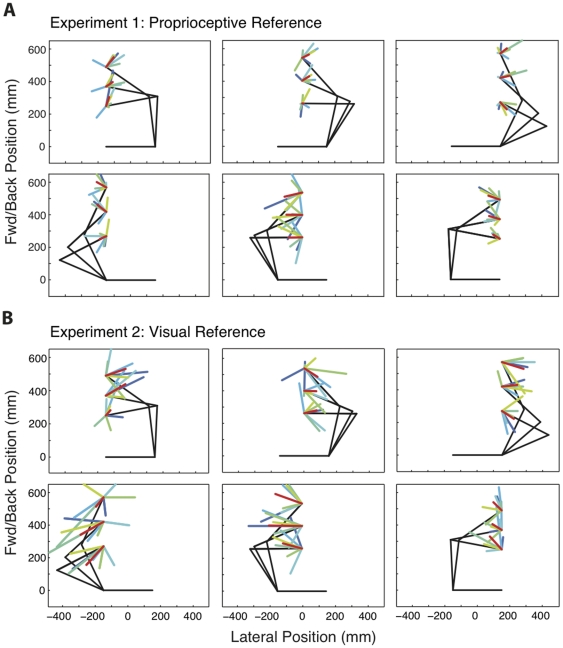
Proprioceptive Bias across the workspace.Proprioceptive bias is plotted as a vector (the vector sum of bias in the left-right and forward-backward directions) for individual subjects (gray) and the group mean (black), for the left and right hands at three lateral positions and three distances from the body, for Experiment 1 (A) and 2 (B). For purposes of visualization, vector length has been increased by a factor of 20.